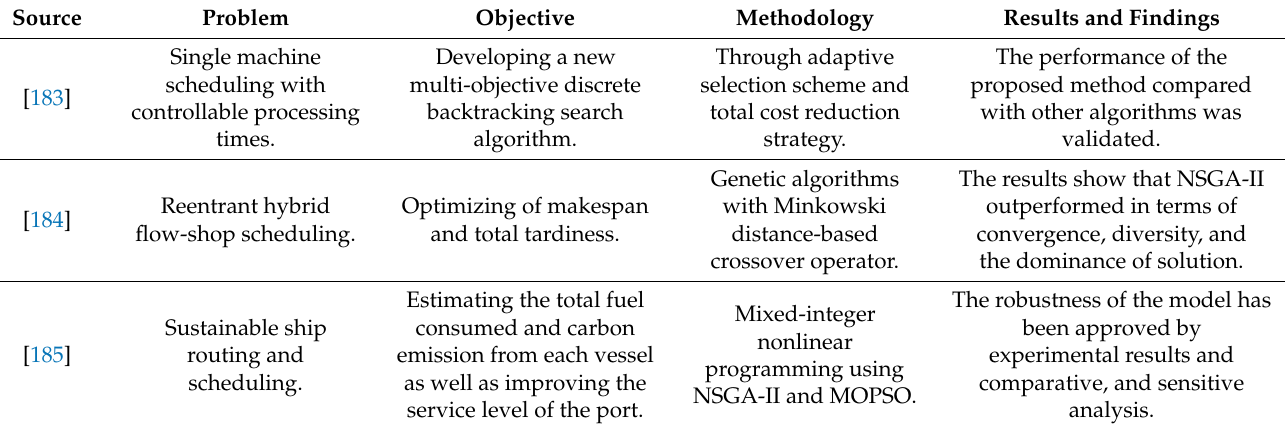
Table 8. Summary of the literature review on NSGA-II applications in different fields, along with methodology and